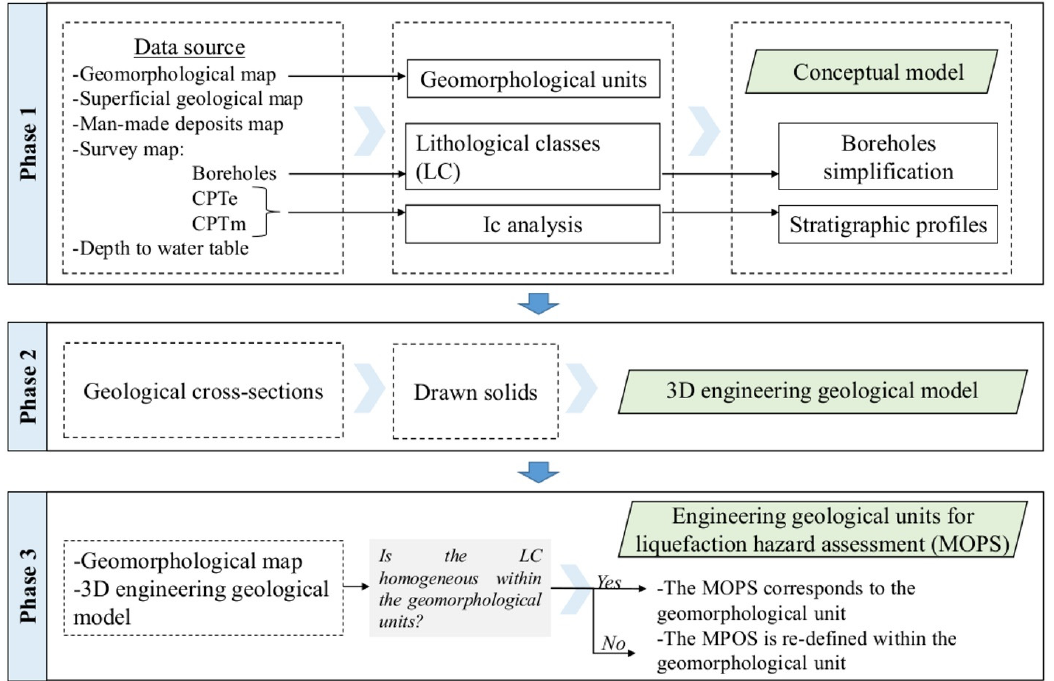
Figure 8. Flow-chart of the methodological approach.